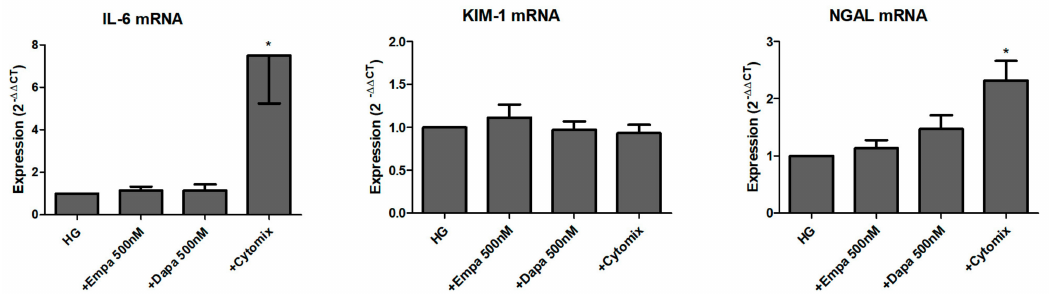
Figure 6. E ff ect of empagliflozin and dapagliflozin on mRNA expression of selected factors. Cells were grown in small culture flasks until confluence, serum depleted for 2 h and stimulated in HG for 24 h. The expression levels in each experiment were normalized to a housekeeping gene ( β -actin) and are expressed relative to the control using the ∆∆ CT method. A mixture of pro-inflammatory cytokines (cytomix) was used as a control, whereas only IL-6 mRNA was significantly increased after incubation with the cytomix (* p < 0.05 versus HG; IL-6 and NGAL n = 6; KIM-1 n = 7).